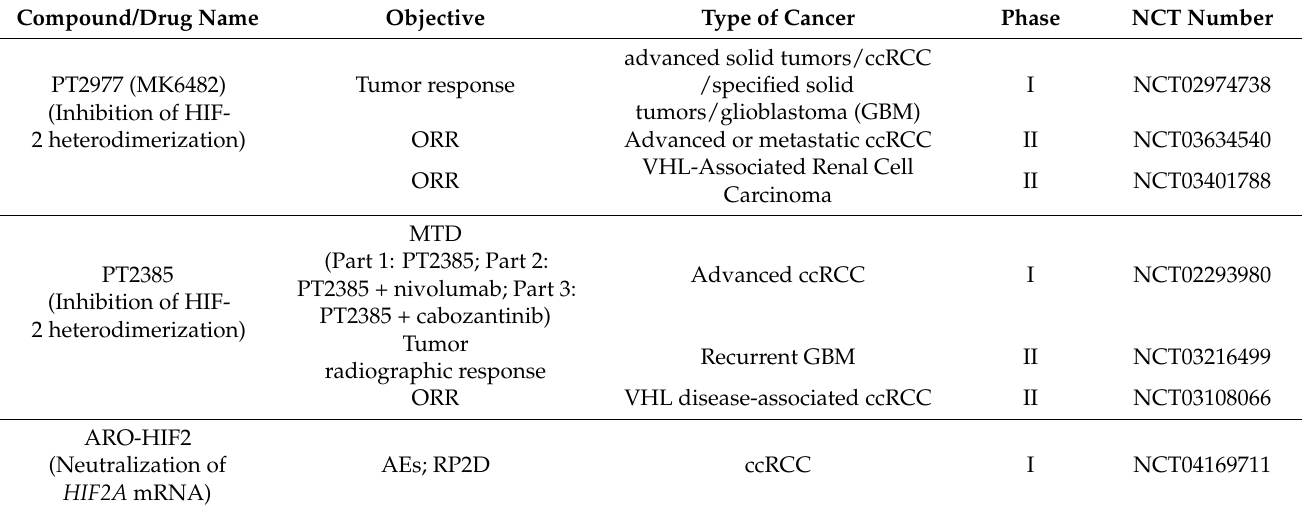
Table 4. Summary of select ongoing clinical trials of HIF-2 α inhibitors in